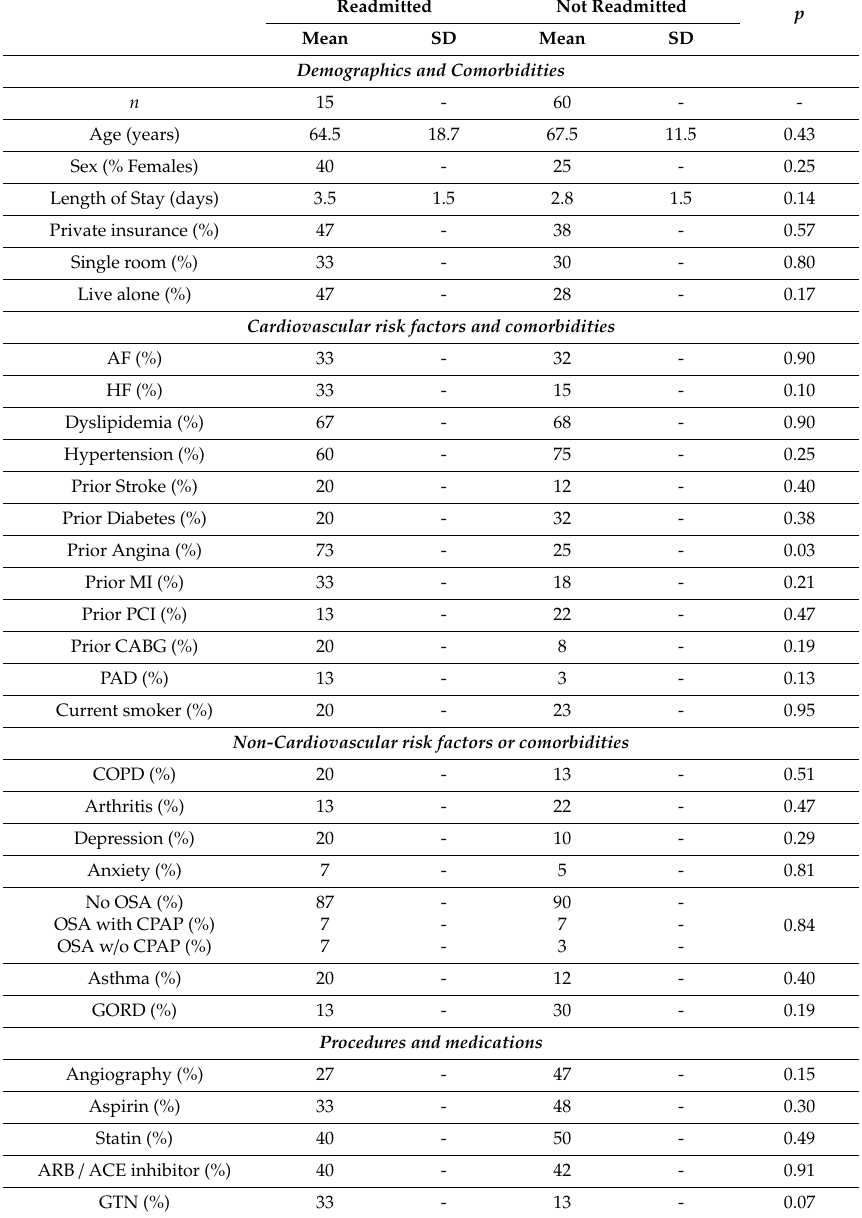
Table 1. Baseline characteristics for unplanned readmitted vs. non-readmitted